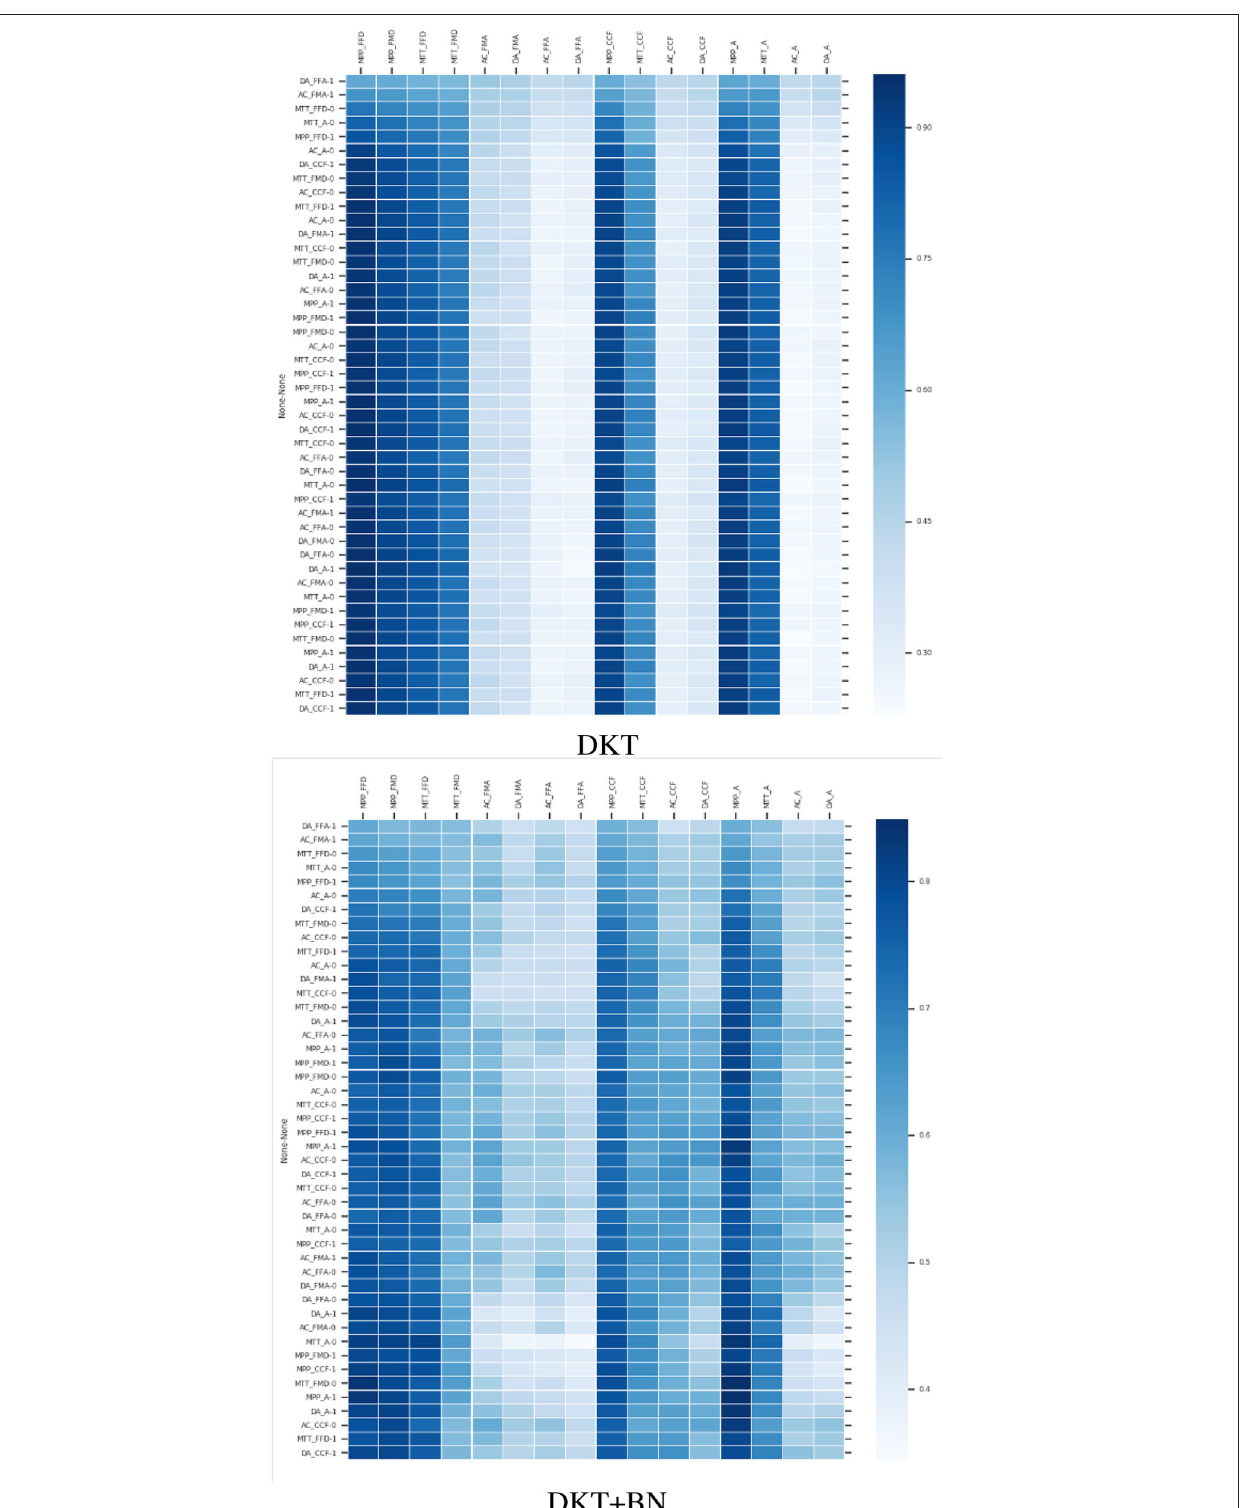
Frontiers in Artificial Intelligence | www.frontiersin.org